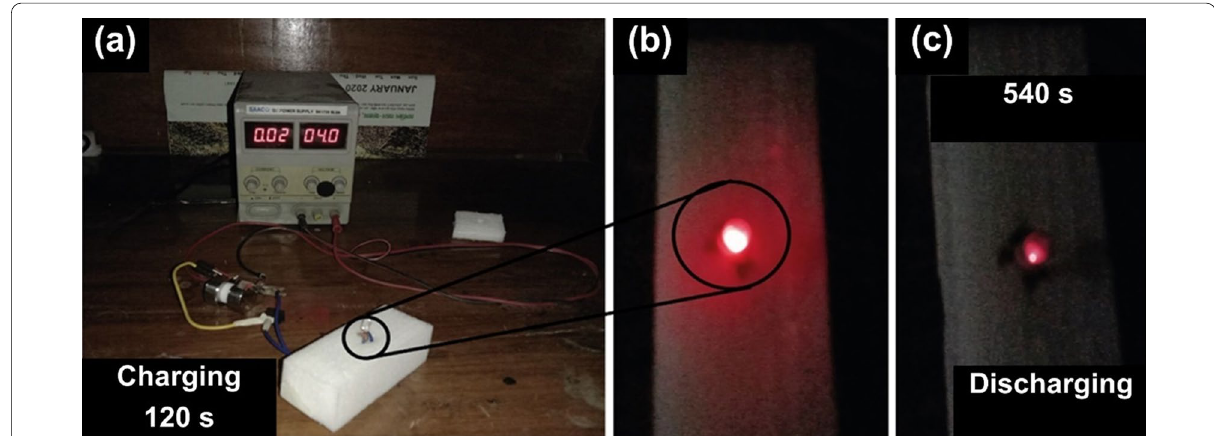
Fig. 8 a The mini-prototype device of MnO x /C-rGO-based symmetric supercapacitor; b and c response tracking with the red LED